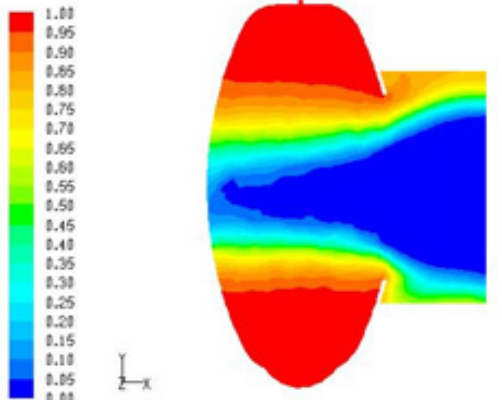
Fig. 4-6. Phase interface, Δ p = 20 kPa, 4x enlarged outlet area. (Attention, error: here, only, the water is red and the air is blue!)